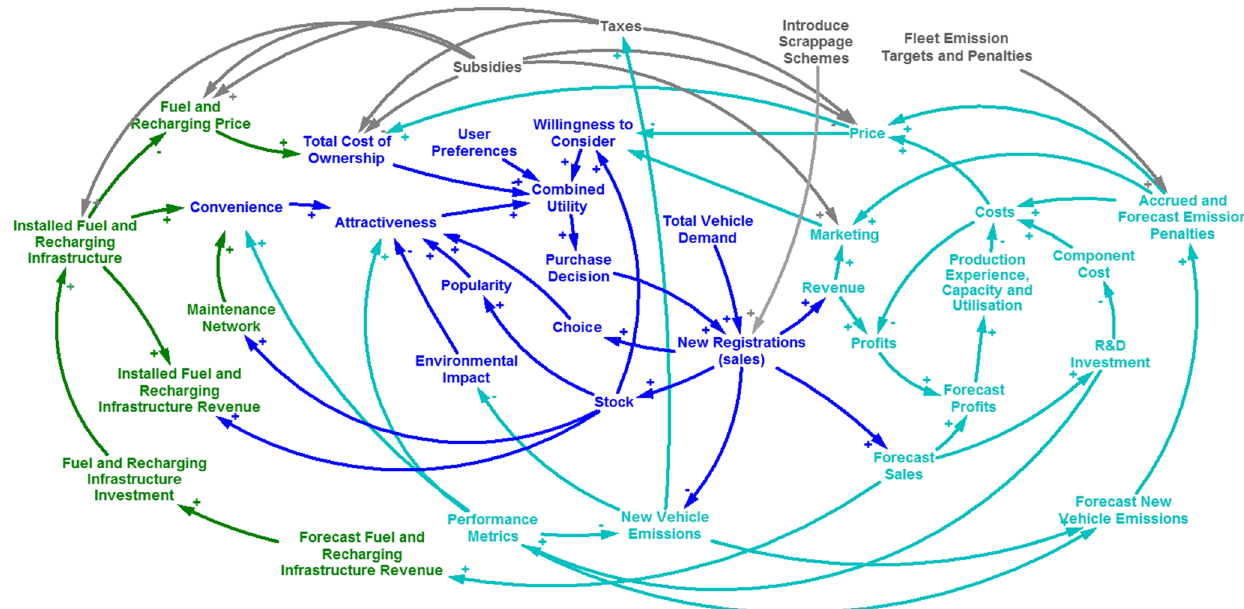
Providers, Turquoise = Manufacturers, Grey = Authorities) (From Technical Report and adapted from Pasaoglu et al.